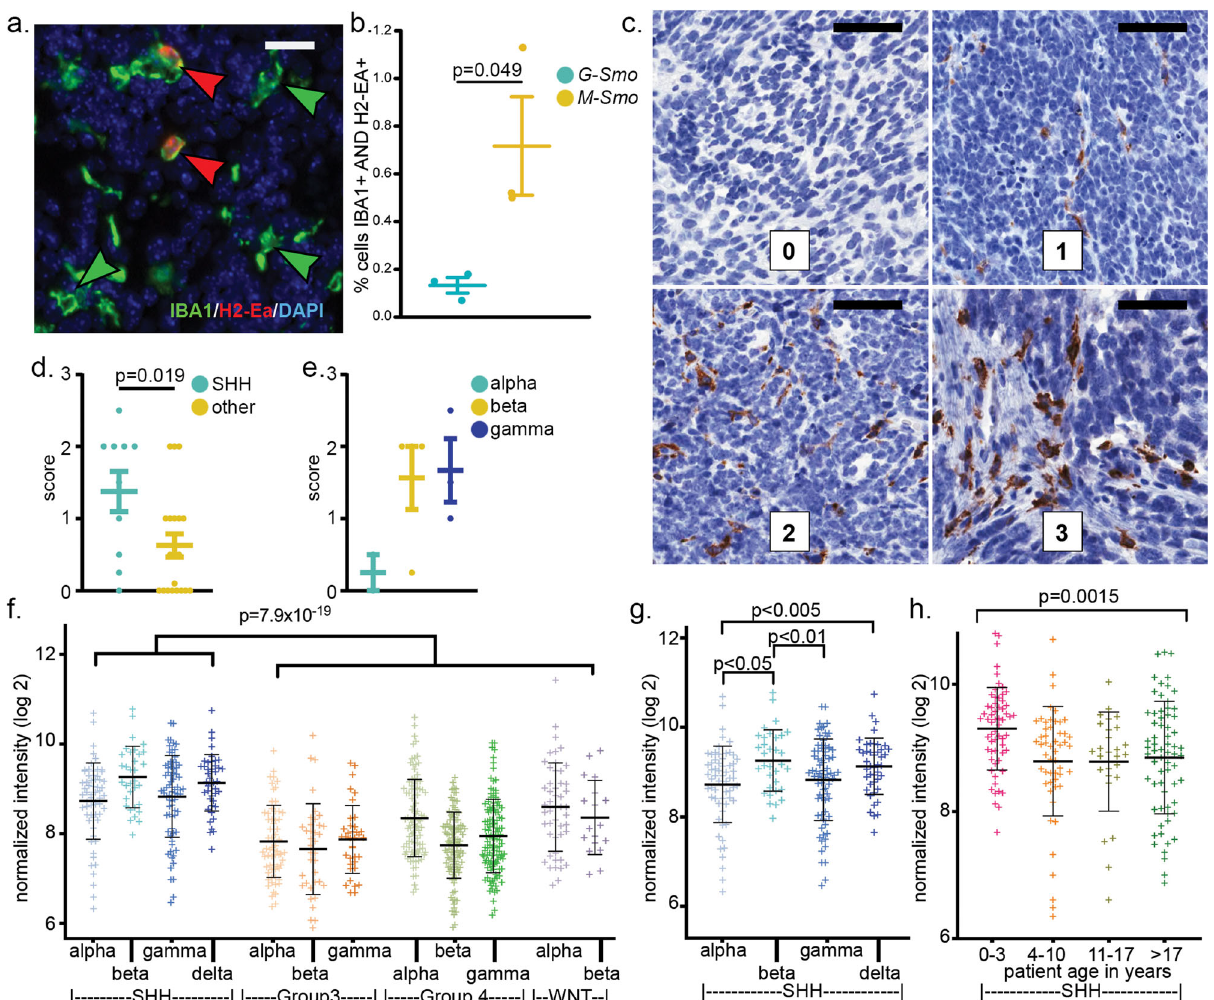
Fig. 7 Differential MHCII/HLA expression in G-Smo versus M-Smo tumors and in human medulloblastoma subsets. a IHC for IBA1 and H2-Ea in a representative M-Smo tumor. b Quanti fi cation of the fraction of IBA1 + /H2-Ea + cells G-Smo and M-Smo tumors. c Representative IHC in human medulloblastomas using a pan-HLA-DR antibody, with scores as noted. d , e Quanti fi cation of the HLA-DR scores of human medulloblastomas for the indicated tumor types. f – h Analysis of HLA-DRA mRNA in published human medulloblastomas microarray data, comparing f SHH-subgroup versus all other subgroups, g SHH-alpha versus each other SHH subtype, or h SHH-subgroup strati fi ed by age. Scale bars = 20 µ m in a and 50 µ m in c . Student ’ s test was used in b , d , e and one-way ANOVA was used in f – h . In all graphs, points represent values for individual replicates, bars indicate the means and whiskers indicate the